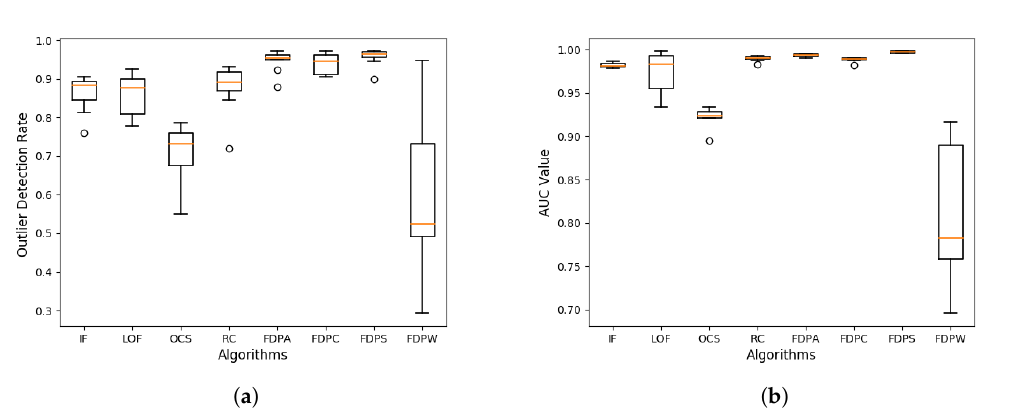
Figure 10. Box plots of the ( a ) outlier detection rates and ( b ) AUCs in the real-world